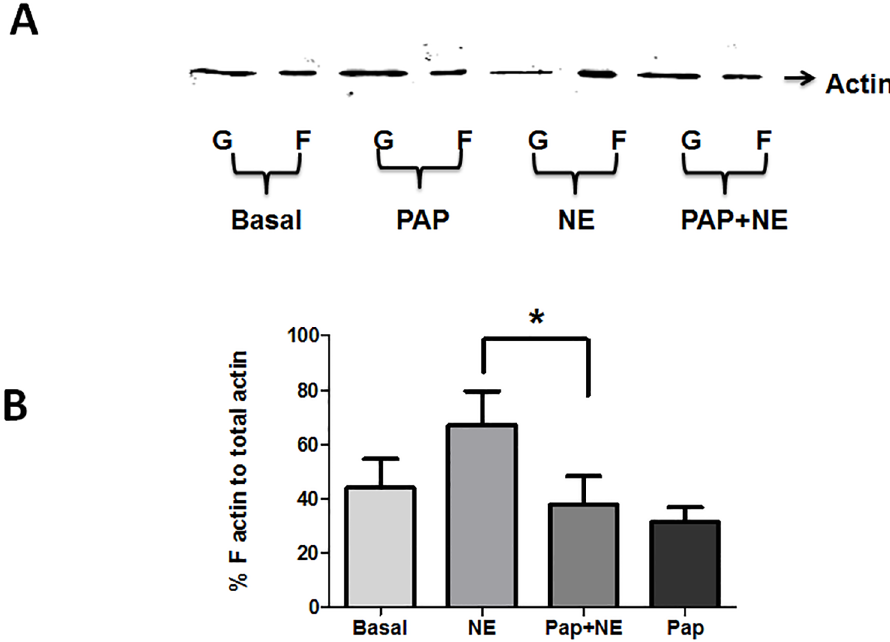
Fig 4. Preincubation with papaverine leads to decreases in F-actin in HSV. HSV rings were suspended in a muscle bath and equilibrated in Kreb ’ s bicarbonate buffer for 2 h. Rings were untreated (Basal) or treated with 1 mM papaverine (Pap) for 10 min, 1 μ M norepinephrine (NE) for 5 minutes, or 1 mM papaverine (Pap) for 10 min followed by 1 μ M norepinephrine for 5 min. Tissues were snap frozen and F- and G-actin were separated by centrifugation and F- actin was quantitated by western blotting and densitometry. % F- actin to total actin (F+G) was calculated. Representative western blots are shown in Panel A with the cumulative bar graphs shown in Panel B. N = 4, * Significant compared to NE, p <